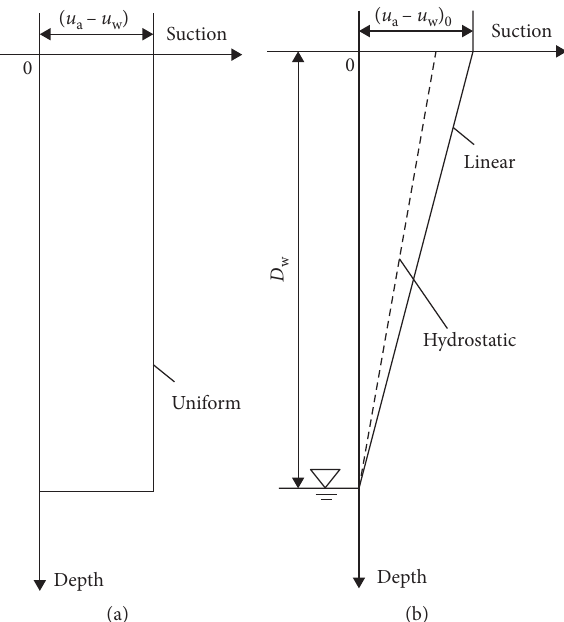
Figure 2: Two profiles of matric suction. (a) Uniform suction. (b) Linear